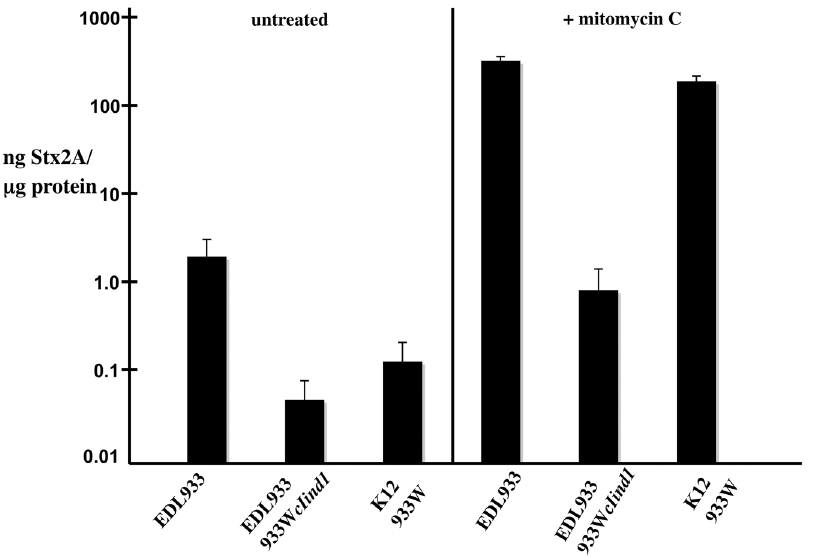
Figure 3. Expression of Stx. Levels of Stx were determined as outlined in Materials and Methods. Mitomycin C was used at a concentration of 2 m g/ml. Strains: EDL933, EDL933 cIind1 (K11349), and K37-933W (K9675). Error bars indicate standard deviations. P values (mc=mitomycin C treated): (1) EDL933 6 EDL933 (mc)=6.6 6 10 2 7 ; (2) EDL933 6 K11349=0.0056; (3) K11349 6 K11349 (mc)=0.018; (4) EDL933 6 K9675=0.0069; (5) K9675 6 K9675 (mc)=3.5 6 10 2 6 ; (6) EDL933 (mc) 6 K9675 (mc)=0.00044.